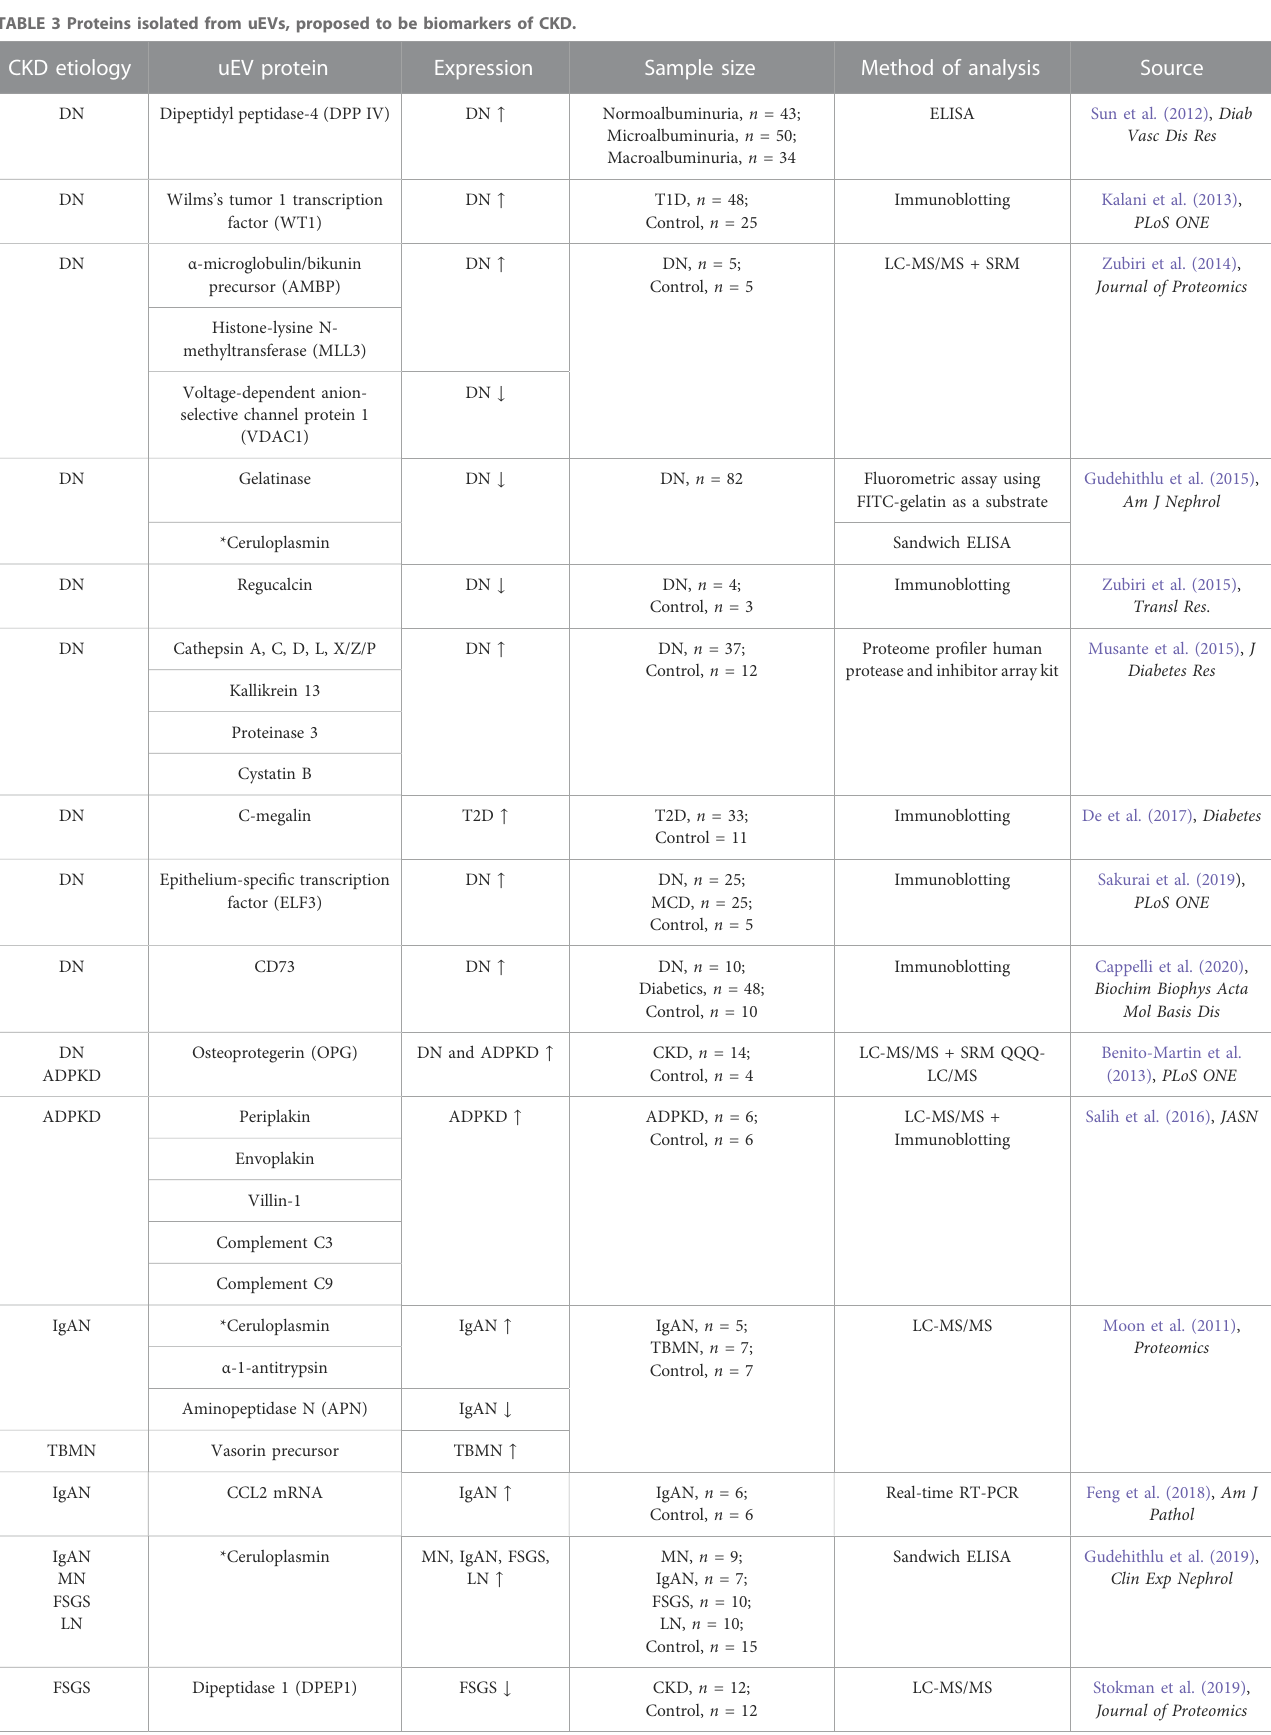
TABLE 3 Proteins isolated from uEVs, proposed to be biomarkers of